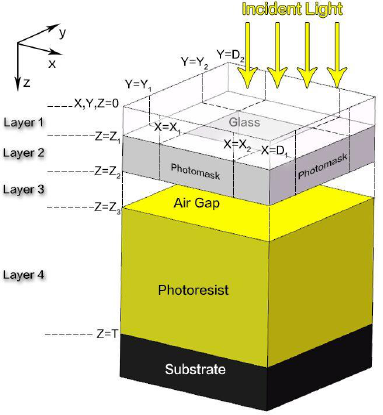
Figure 3. Three-dimensional schematic of the waveguide method.